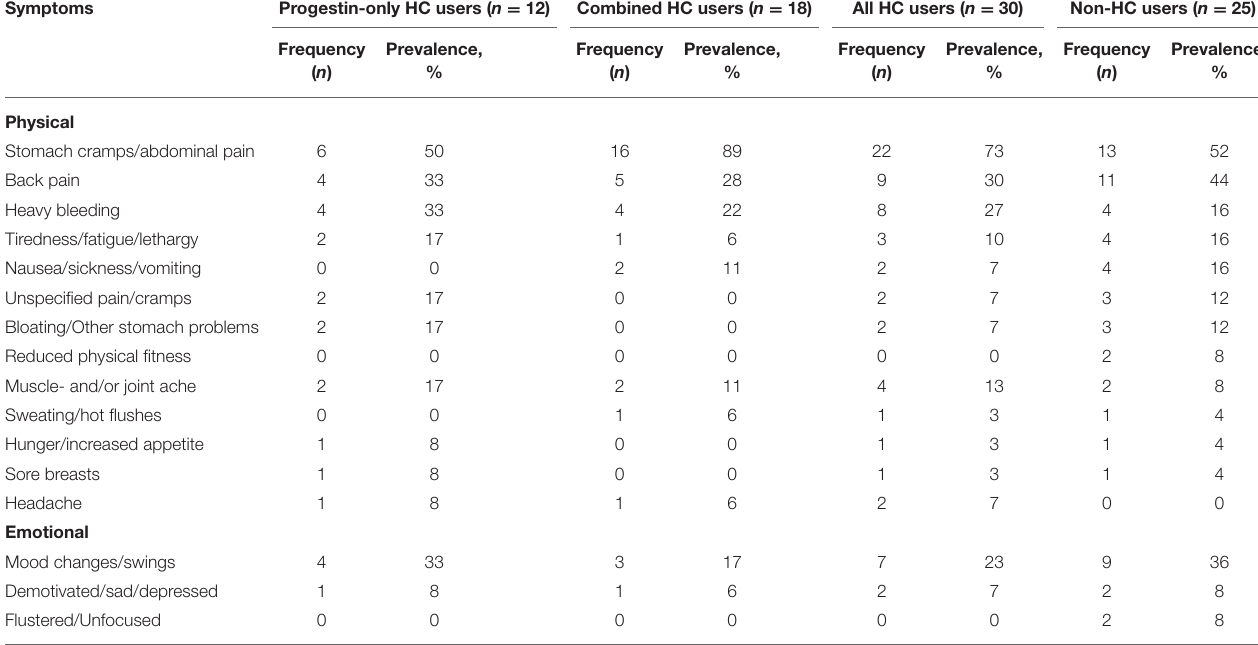
TABLE 4 | Prevalence of reported menstrual symptoms for progestin-only and combined hormonal contraceptive (HC) users, and for all HC users and non-HC users. Symptoms Progestin-only HC users ( n =